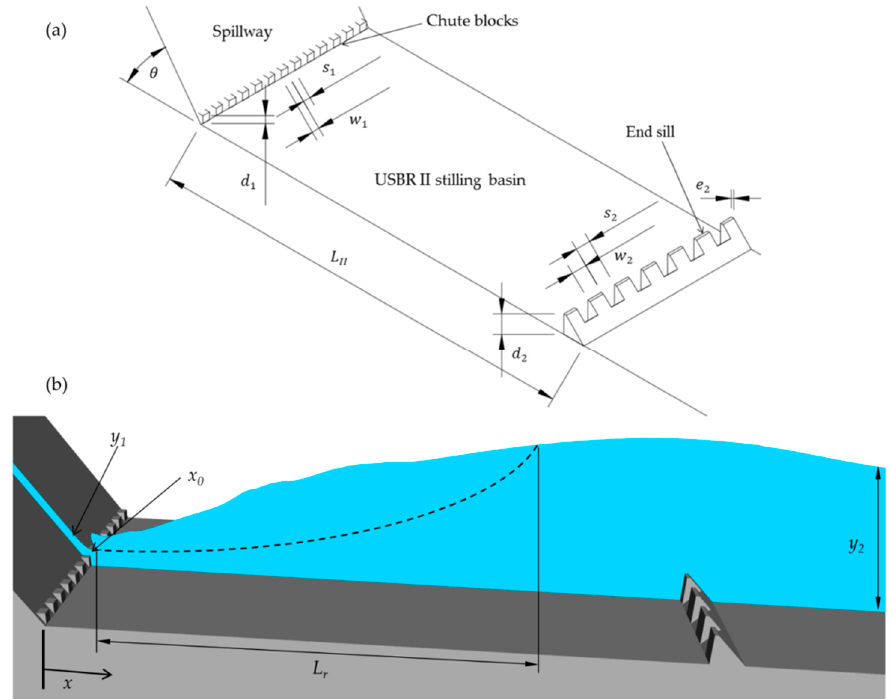
Figure 1. Design of the typified United States Bureau of Reclamation (USBR) II stilling basin physical model (flow from left to right): ( a ) Stilling basin including the design parameters: d 1 , w 1 and s 1 are the height, width and spacing of the chute blocks, whereas d 2 , w 2 and s 2 are these same values but for the blocks in the end sill. L II is the length of the basin, e 2 is the width of the end sill top face and θ is the angle formed with the slopping channel; ( b ) sketch of the hydraulic jump along the stilling basin longitudinal axis. Table 1. Dimensions of the typified USBR II stilling basin physical model.